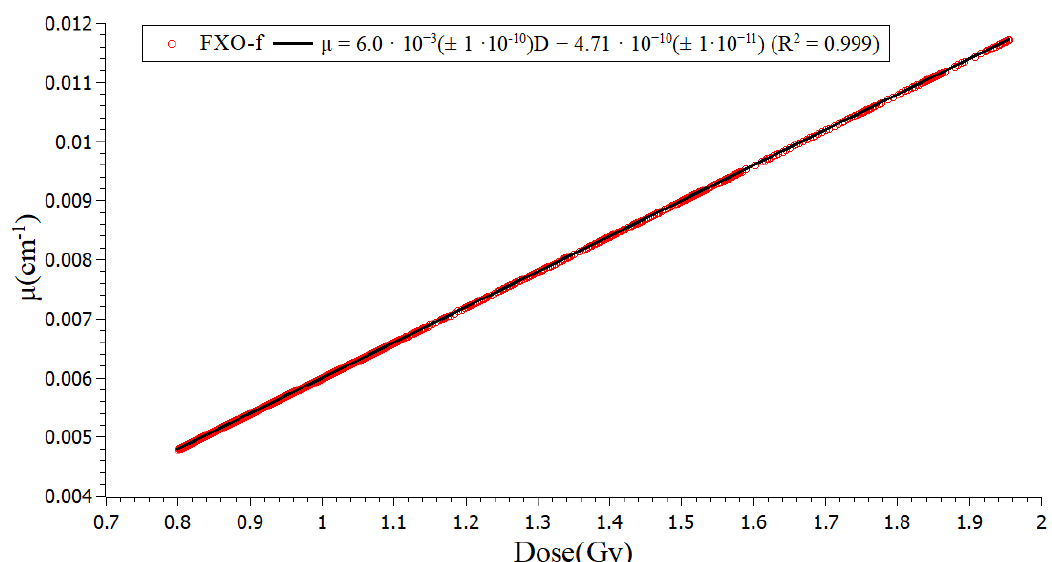
Figure 2. Calibration curve relating the optical attenuation coefficient (µ) achieved in the PDD OCT and absorbed dose delivered at the same point. A sensitivity of 6.0·10 −3 cm −1 /Gy was achieved. Calculated points are in red and linear fitting is the black line.